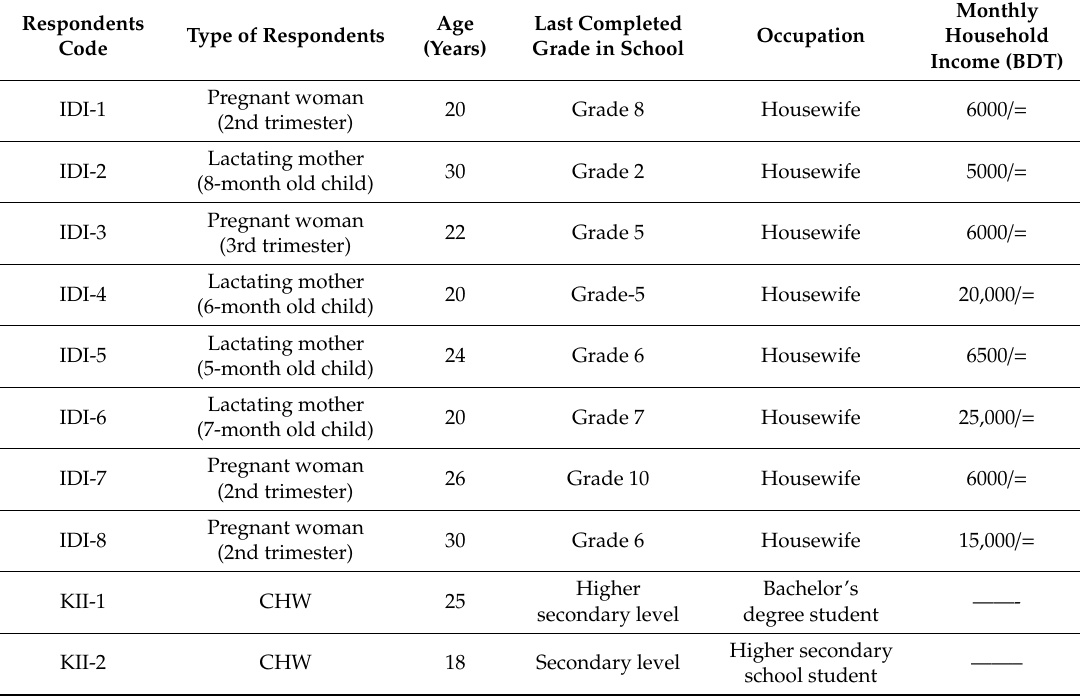
Table 5. Participants’ characteristics of qualitative